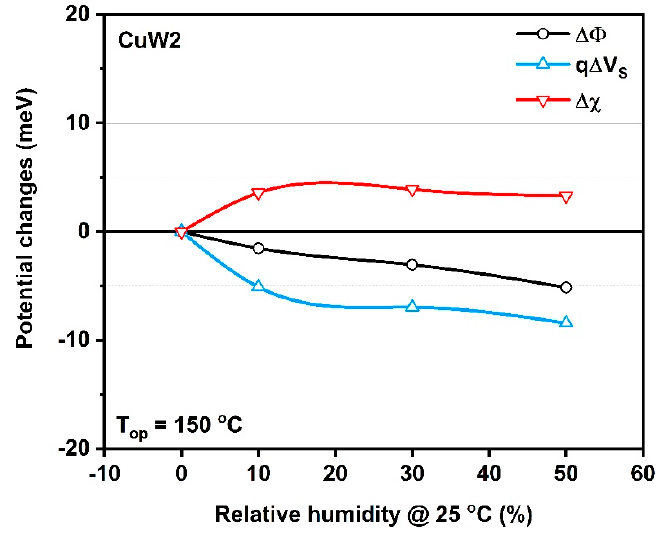
Figure 10. Potential changes at the CuW2 surface induced by RH variations .